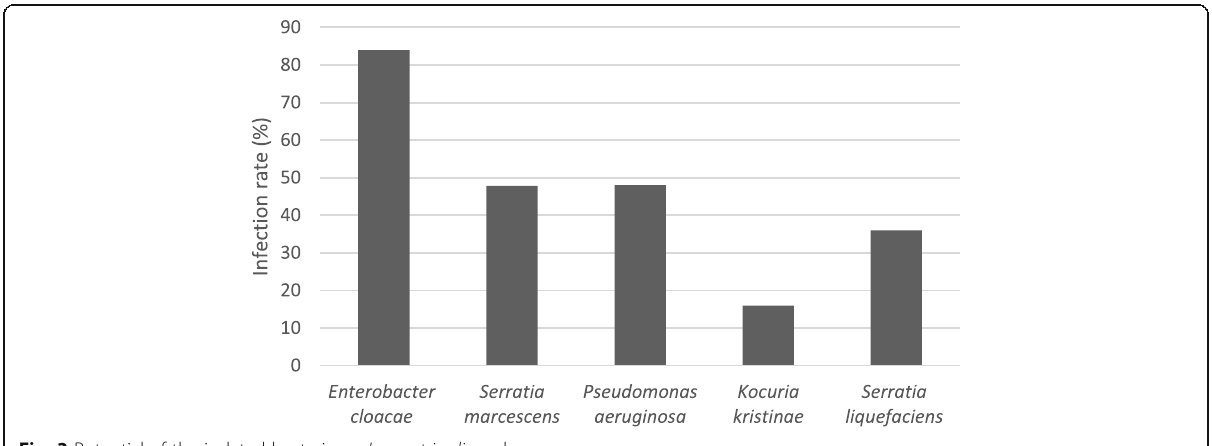
Fig. 3 Potential of the isolated bacteria on Lymantria dispar